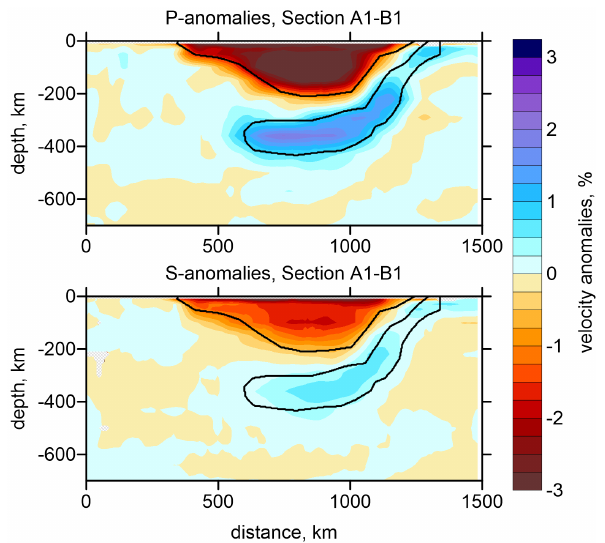
Figure 7. Synthetic test with a synthetic model of realistic configu- ration. The shape of the synthetic model is highlighted with a con- tour. The thickness of the anomaly in the direction across the section is 200km.